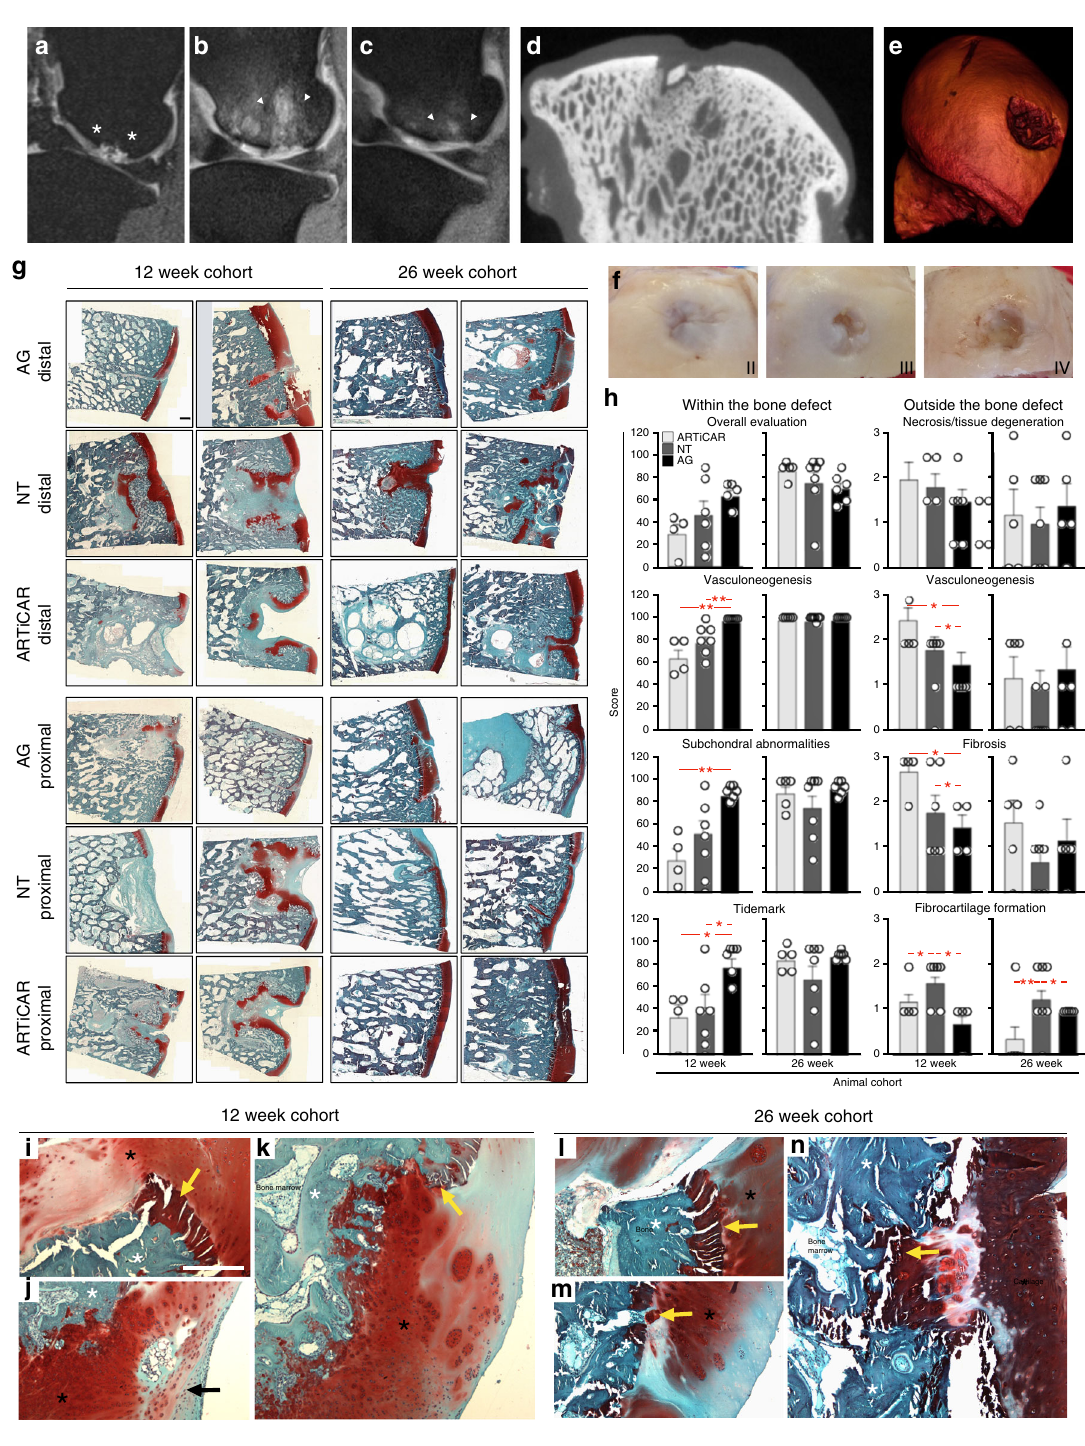
Fig. 4 Feasibility, non-invasive monitoring and safety evaluation of the ARTiCAR combined ATMPs implanted in sheep intra-articular defect model. a – e the OAR process after ARTiCAR implant was monitored non-invasively by means of MRI immediately after surgery ( a ) and at 12 ( b ) and 26 ( c ) weeks post implant. The extension of the bone defect (white asterisks) and the ongoing OAR (white arrowheads) are visible. Micro CT-scan ( d ) followed by 3D surface rendering ( e ) were performed on freshly explanted joints. f The level of cartilage regeneration was macroscopically assessed based on ICSR score system. g , h Whole explants were sectioned and stained with safranin o - fast green (blue: bone; red: cartilage), imaged at ×4 and stitched together ( g ) to evaluate the OAR according to the ICRS II score system ( g ). Scale bar: 1 mm. ICRS II parameters were examined for ARTiCAR and the control groups considered and analyzed by mean of two-way ANOVA followed by Bonferroni post hoc test ( h ). * = p ≤ 0.1; ** = p ≤ 0.05. Dots represent individual scores, bars represent mean scores and error bars represent standard errors. ( i – n ) Zones of osteochondral remodeling within the treated defects in animals from AG (I,L), NT ( j , m ) and ARTiCAR ( k , n ) groups, either at 12 or 26 weeks post implant. Bone (white asterisks), cartilage (black asterisk), fi brocartilage (black arrow) and subchondral bone (yellow arrow) are shown. Scale bar: 500 µ